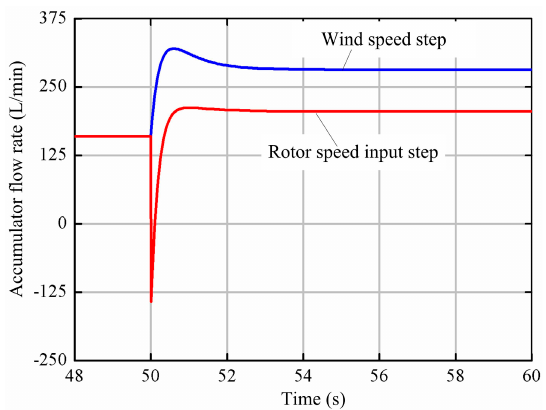
Figure 12. Accumulator flow rate.